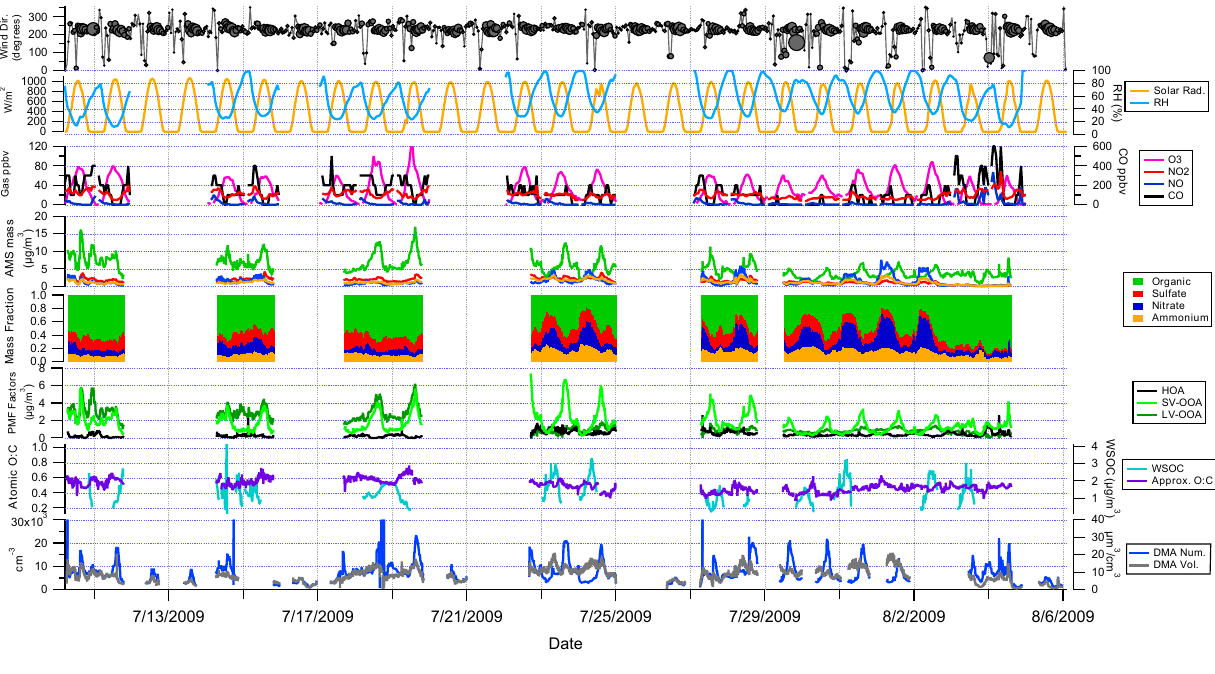
Fig. 1c. Regime III (wind direction marker size proportional to wind speed; max size = 20 km/h).